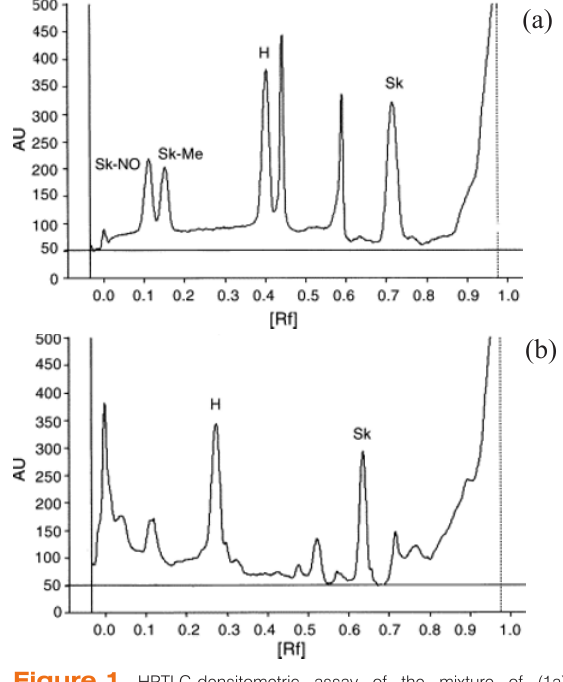
Figure 1. HPTLC-densitometric assay of the mixture of (1a) scopolamine–N-oxide (Sk–NO), scopolamine–N-methyl bromide (Sk-Me), l-hyoscyamine (H) and scopolamine (Sk). Stationary phase: silica gel 60 F254 HPTLC plates, 20×10 cm, 0.25 mm thickness; mobile phase: (a)